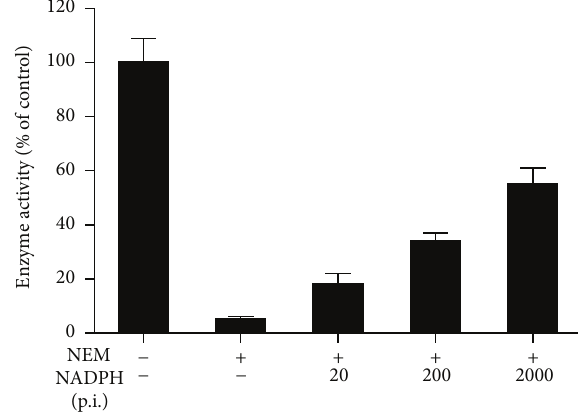
Figure 3: Preincubation with NADPH protects 17 𝛽 -HSD1 from inhibition by NEM. Lysates of HEK-293 cells expressing 17 𝛽 -HSD1 were preincubated for 15min with saline or various concentra- tions of NADPH as indicated, prior to the addition of estrone (200 nM), NADPH (400 𝜇 M), and the sulfhydryl modifying agent N-ethylmaleimide (NEM, 60 𝜇 M). The estradiol produced was determined after 10min of incubation. Data (mean ± SD) were normalized to the control in the absence of NEM and were obtained from at least three independent experiments measured in